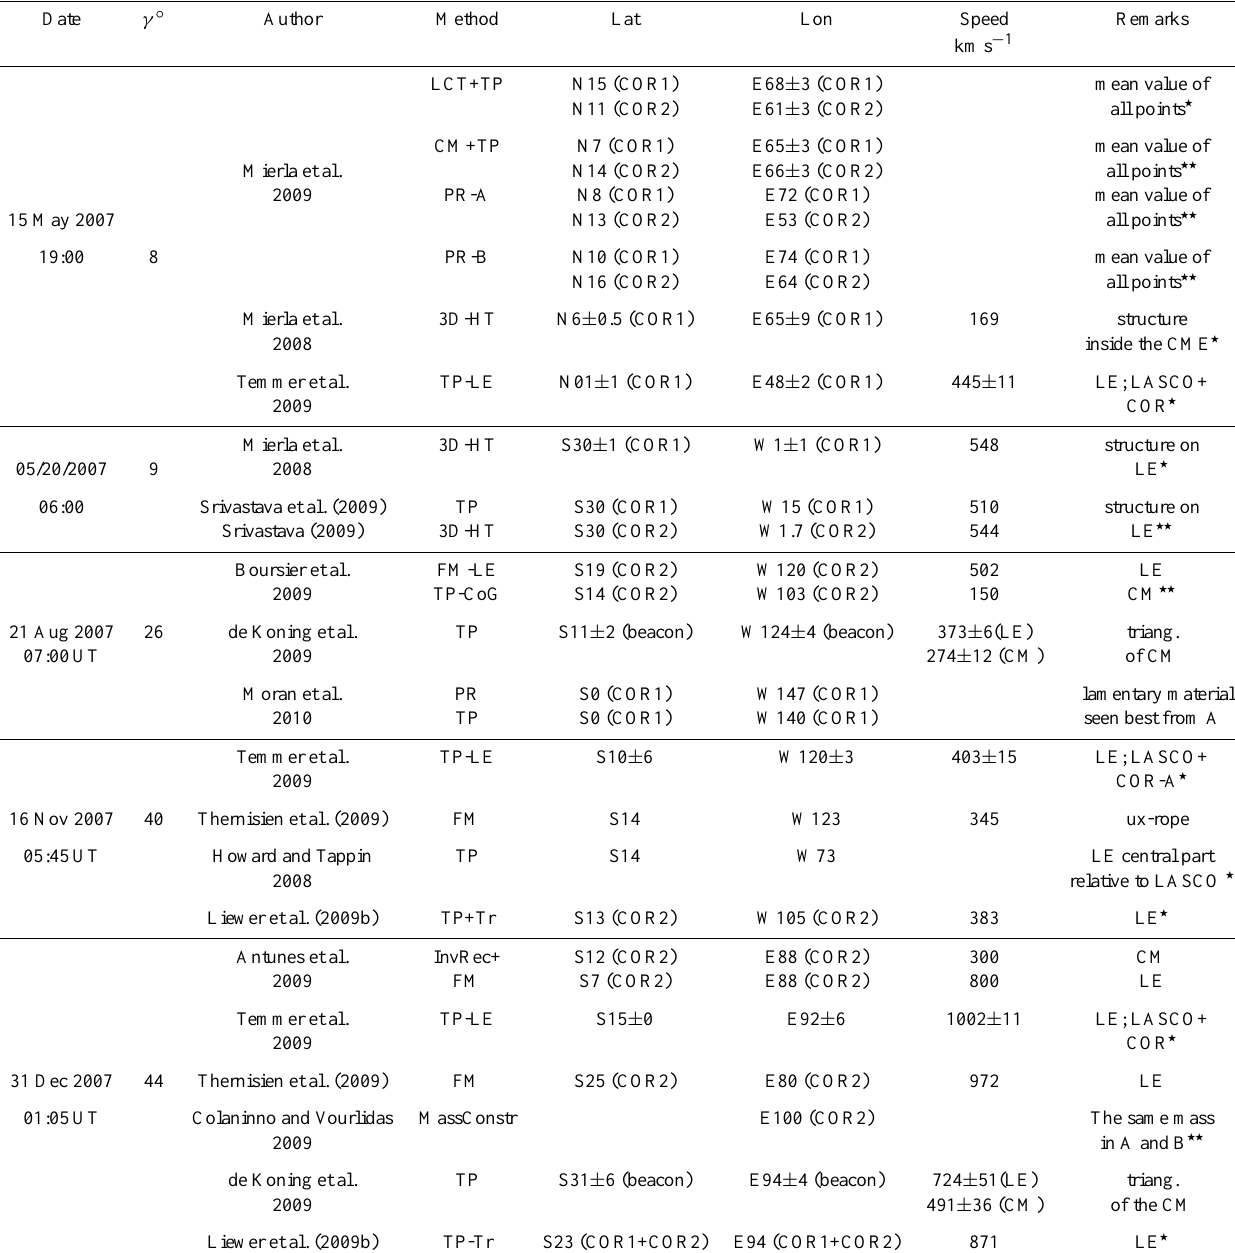
Table 2. Values of parameters for different events reconstructed using different methods applied on COR and LASCO data. The errors for different methods are estimated as described in Sect. 5.1. ? means that identifying the same feature in all spacecraft is required and ?? means that the entire CME should be seen in all spacecraft for the methods to work. The time of each CME is recorded when observed in the COR1